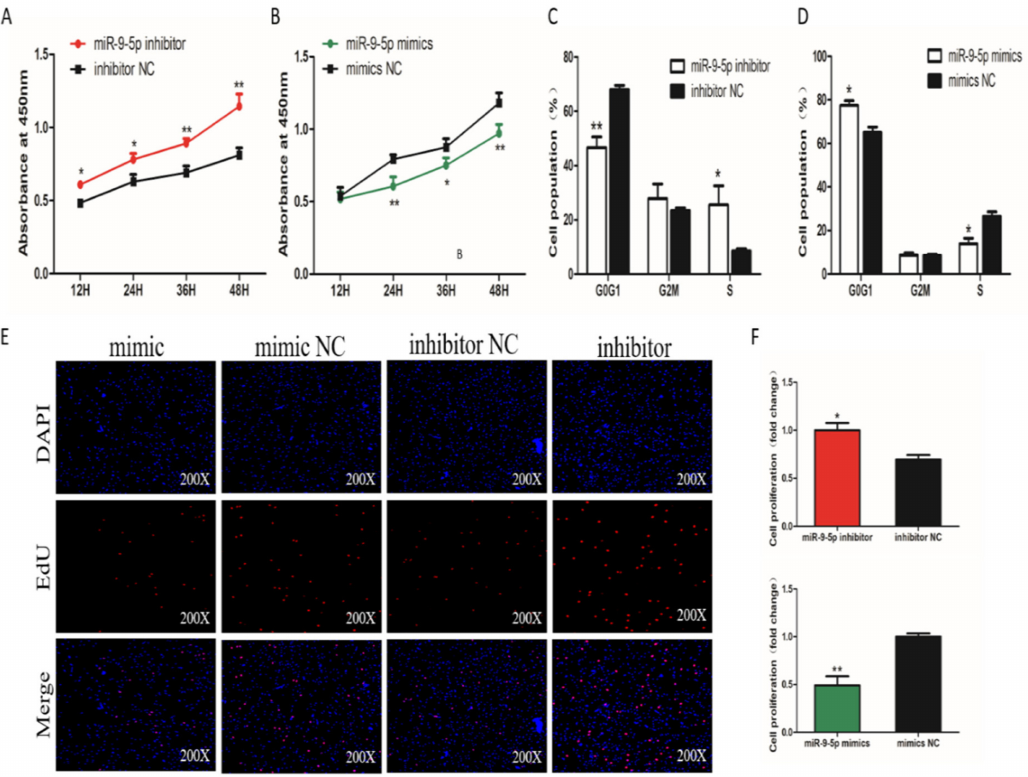
Figure 2. E ff ect of miR-9-5p on the proliferation of SMSCs. ( A , B ) Cell growth curves, as measured using the CCK-8 assay following transfection with a miR-9-5p mimic, inhibitor or negative control (NC) in SMSCs. ( C , D ) Cell cycle analysis of SMSCs 48 h after the overexpression or inhibition of miR-9-5p. ( E ) The results of the EdU assay for SMSCs transfected with a miR-9-5p mimic, inhibitor, or negative control, where EdU (red) fluorescence is used as an indicator of proliferation, and nuclei are indicated by DAPI (blue) fluorescence. Photomicrographs were taken using a 200 × magnification. ( F ) The proliferation rates of SMSCs with miR-9-5p overexpression and inhibition. The data are expressed as mean ± SEM ( n = 6). * p < 0.05; ** p < 0.01 vs.